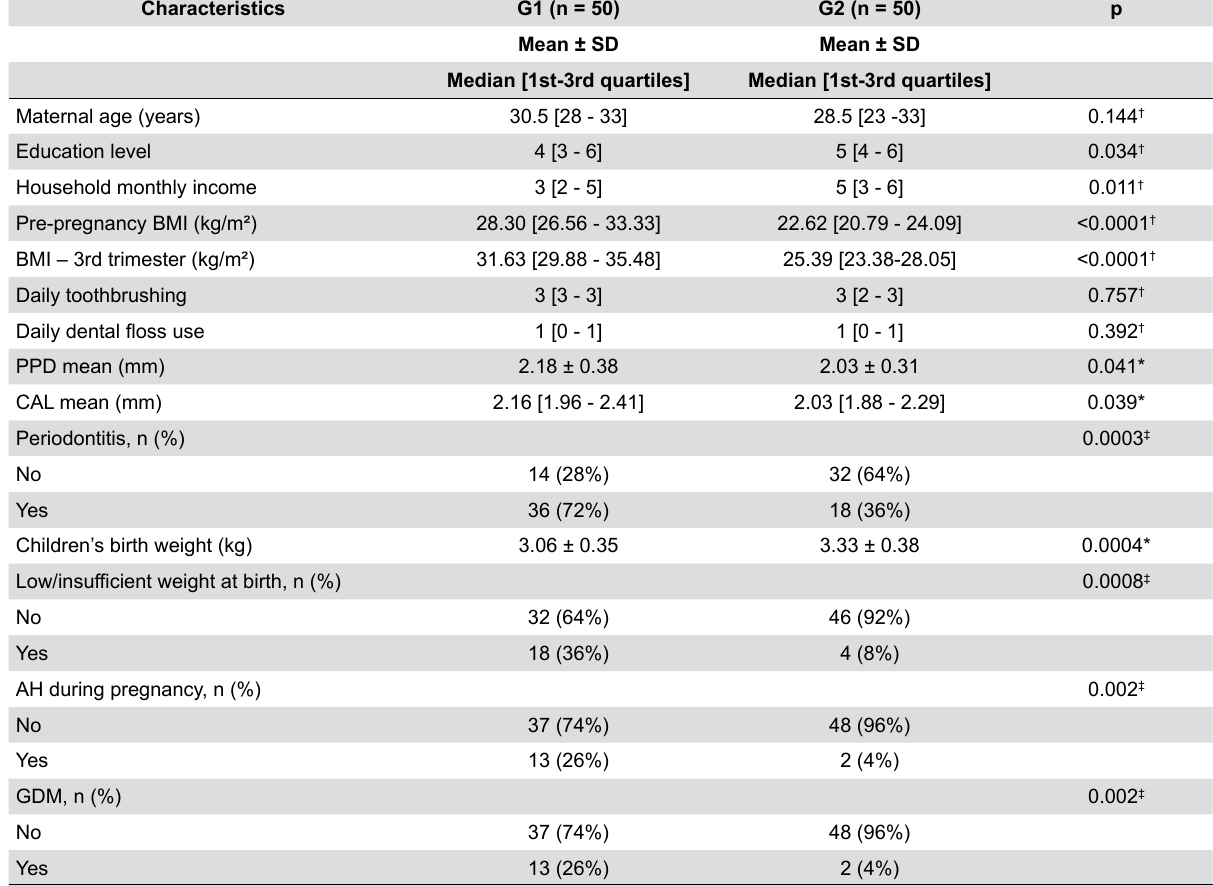
Table 1- Comparison between the groups regarding contextual, periodontal, and systemic